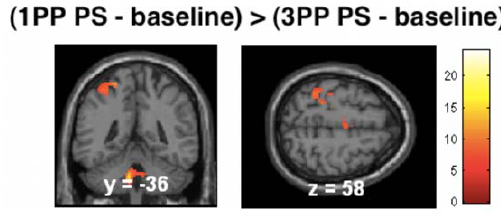
Figure 4. Statistical maps for the contrast 1PP (PS - baseline) relative to 3PP (PS - baseline). Results show brain activation in SI for 1PP (at p , 0.05, FWE corrected, masked with real touch . baseline). The contrast 3PP (PS - baseline) relative to 1PP (PS - baseline) failed to show any significant voxels (at p , 0.05, FWE corrected).